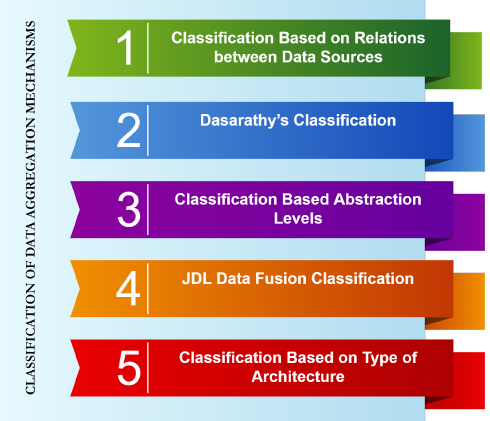
Figure 5. Classification of mechanisms for data aggregation by F.